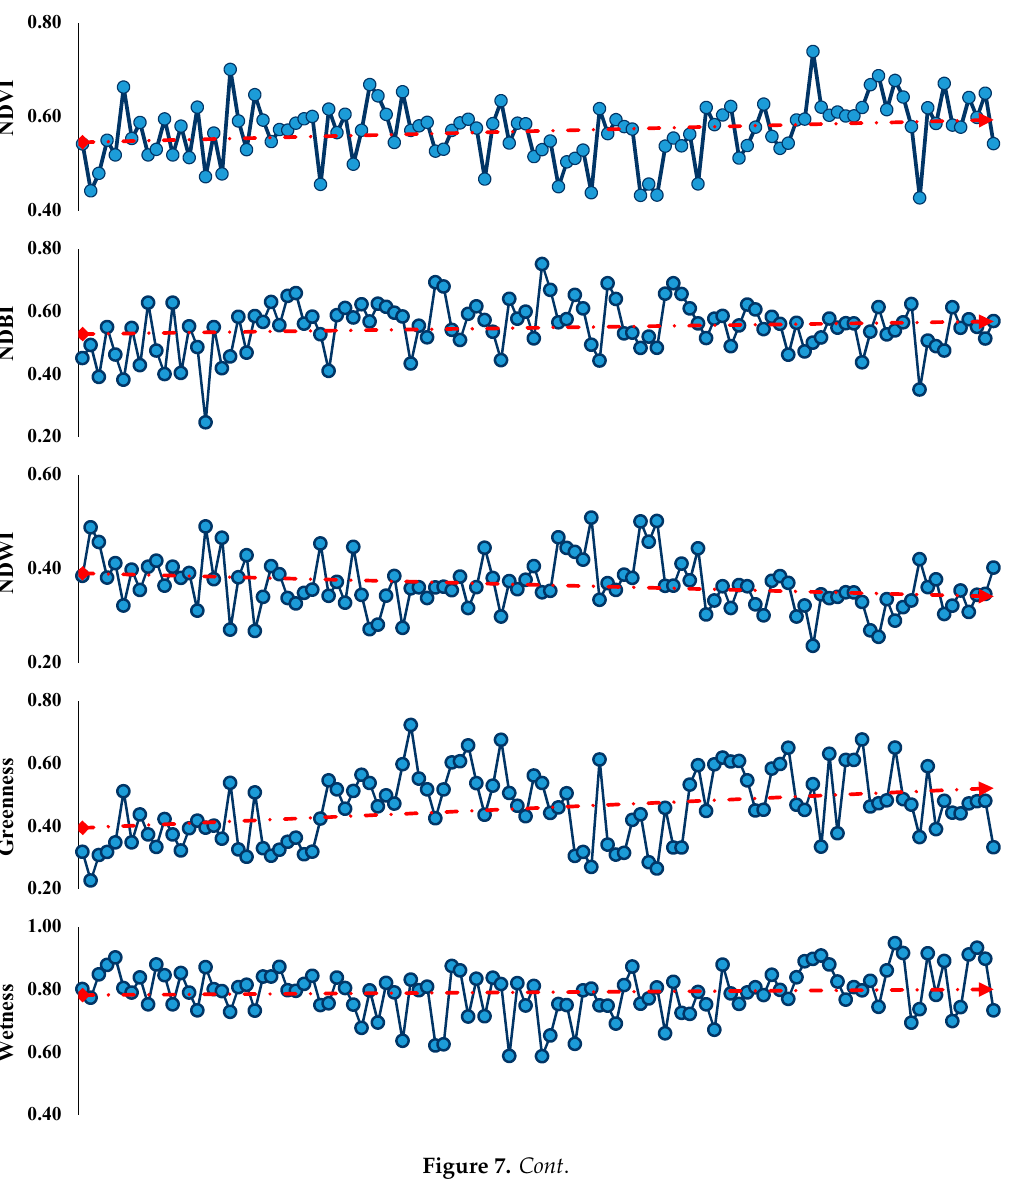
Figure 6. The mean LST in Babol, Iran, from 1985 to 2018 (°C).